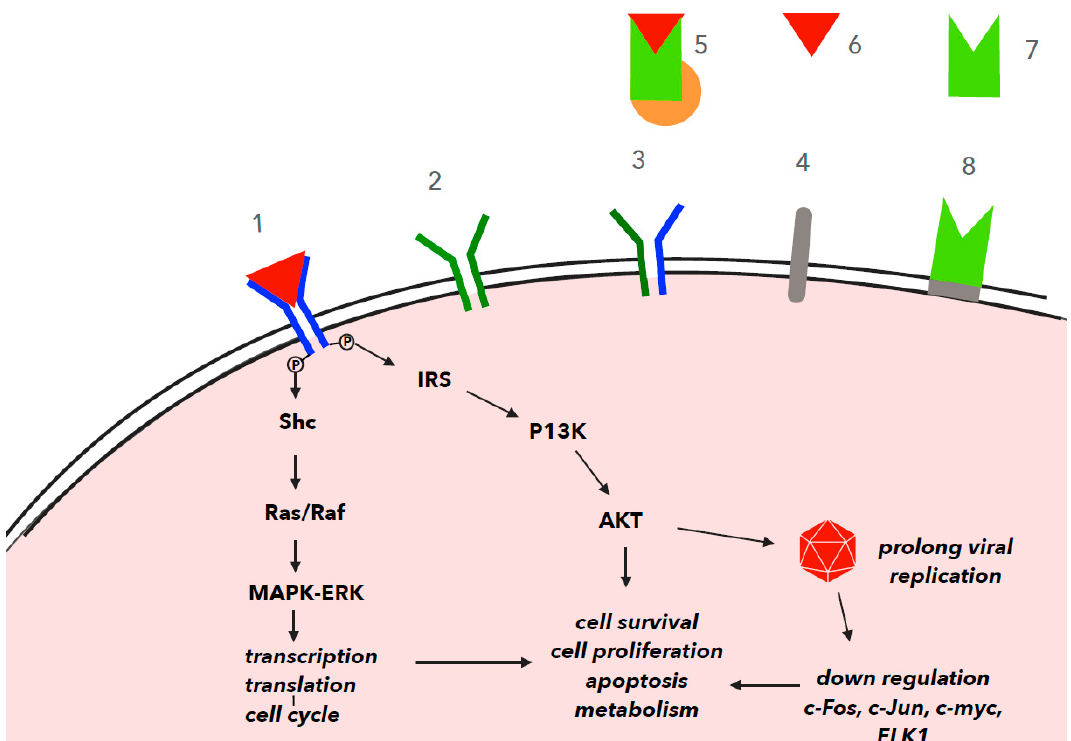
Figure 1. IGF-1 signal transduction via IGF-1 receptor (IGF-1R) in viral infections. The phosphorylated tyrosine residues of IGF-1R act as docking stations for substrates, such as insulin receptor substrate (IRS) and Shc adaptor proteins, and then recruit additional factors to activate two major cascades, the phosphatidyl inositol 3-kinase (PI3K) and mitogen-activated protein kinase (MAPK) pathways. Ras/Raf participates in the activation of the MAPKs ERK1 and ERK2, which